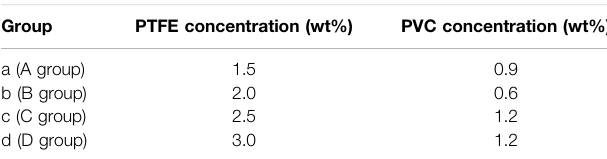
TABLE 4 | Results of optimal particle